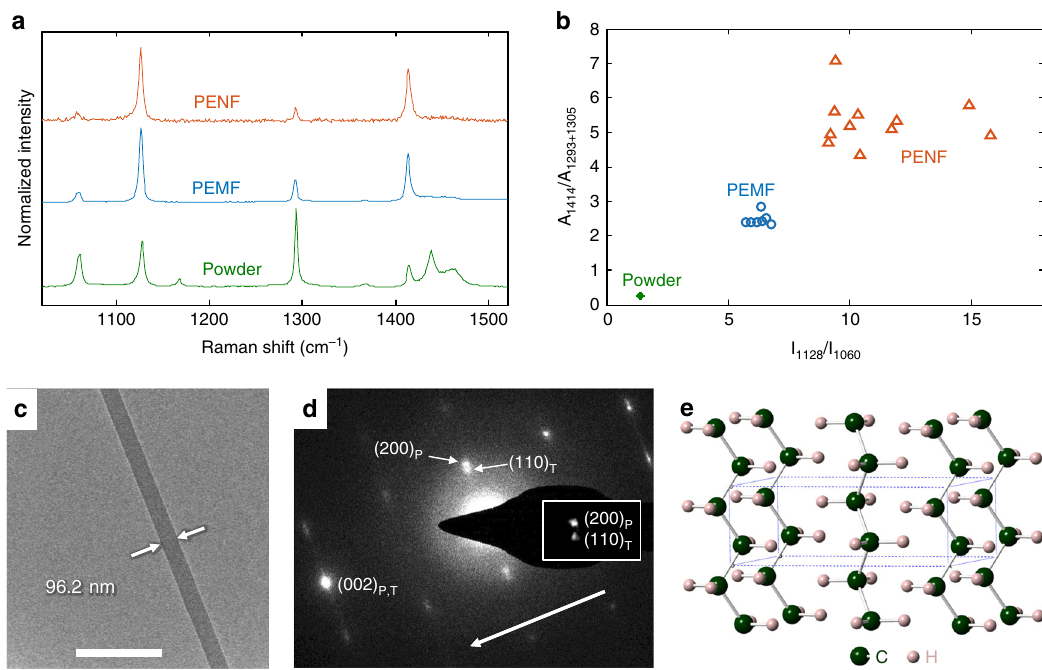
Fig. 2 Morphological and structural characterizations. a Micro-Raman spectra of PE powder, PEMF and PENF where the data is normalized to the highest peak of each spectrum. b Ratio of integral areas of Raman band 1414 cm − 1 to Raman bands 1293 cm − 1 and 1305 cm − 1 vs. intensity ratio of Raman bands 1128 cm − 1 to 1060 cm − 1 . c TEM micrograph of a PENF. d SAED pattern of the PENF in c Inset shows the distinct diffraction spots of (200) plane of parent crystal (subscript P) and (110) plane of twinned crystal (subscript T). Arrow indicates the drawing direction. e Orthorhombic crystal structure of PE. Scale bar, 500